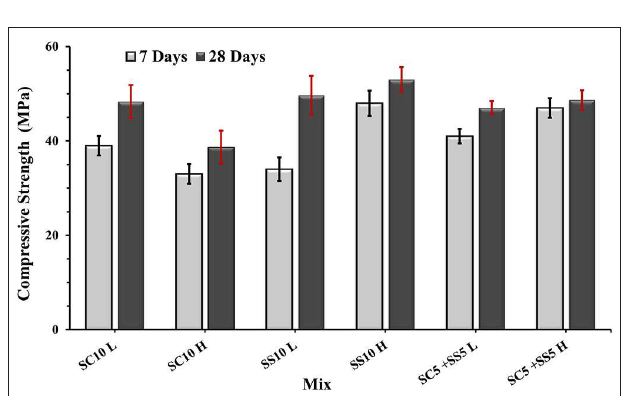
FIGURE 4 | Compressive strength test results of concrete cubes after 7 and 28 days of sealed